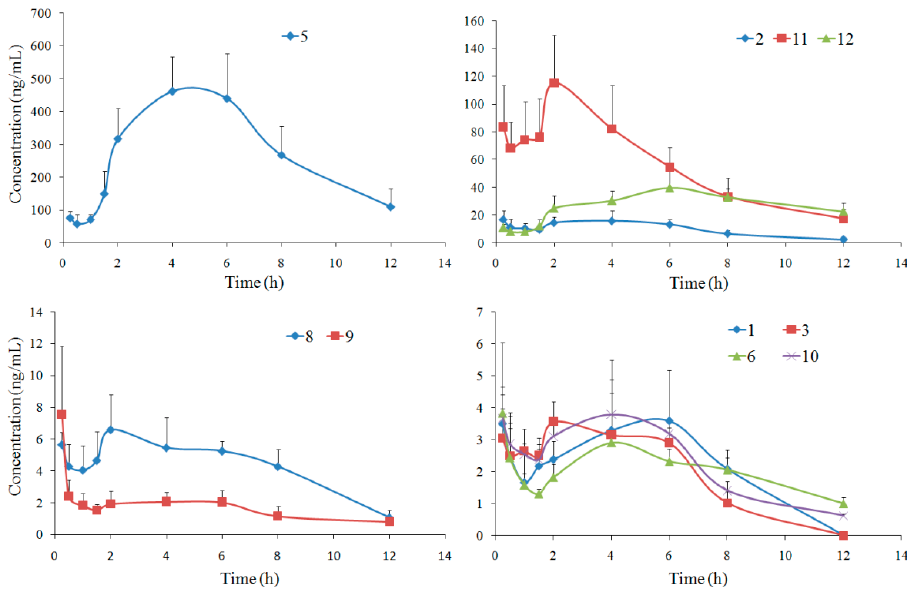
Figure 3. Mean concentration-time curves of ten compounds in rat CSF after oral administration of APRE (mean ± SD, n = 6). Coumarins 4 and 7 were unable to be determined since their MRM responses in CSF were under LLOQ. Table 2. Pharmacokinetic parameters of ten analytes * in rat CSF after oral administration of APRE (mean ± SD, n = 6).